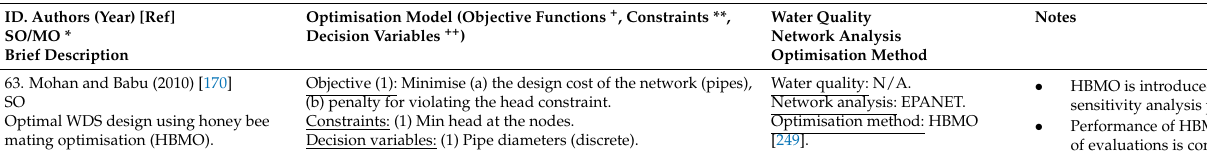
Optimal WDS strengthening, expansion, rehabilitation and operation with a